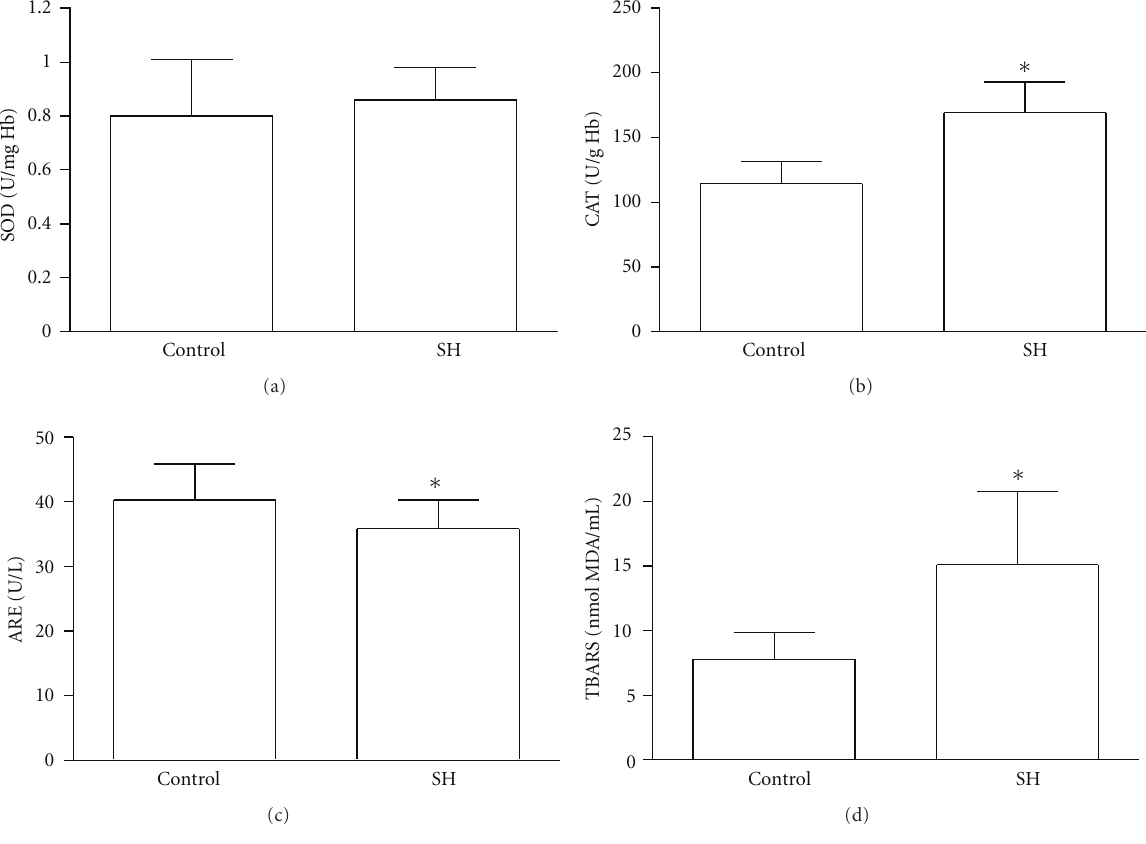
that increased LPO could be attributed to lipid levels in et al. (2008), where a significant correlation between TSH and MDA was lost after nullifying the e ff ects of each of the coronary lipid risk factors among hypothyroid subjects